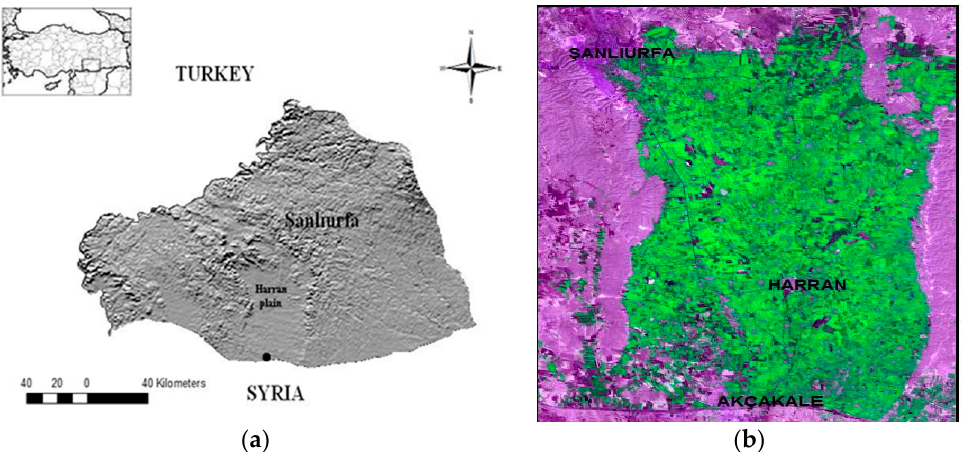
Figure 2. Ş anl ı urfa and Harran Plain: ( a ) the places of Ş anl ı urfa and Harran Plain in Turkey; ( b ) Figure 2. ¸Sanlıurfa and Harran Plain: ( a ) the places of ¸Sanlıurfa and Harran Plain in Turkey; ( b ) irrigated irrigated area of the Harran Plain (Source: Prof. Dr. Mehmet Ali Çullu, Harran University). area of the Harran Plain (Source: Prof. Dr. Mehmet Ali Çullu, Harran